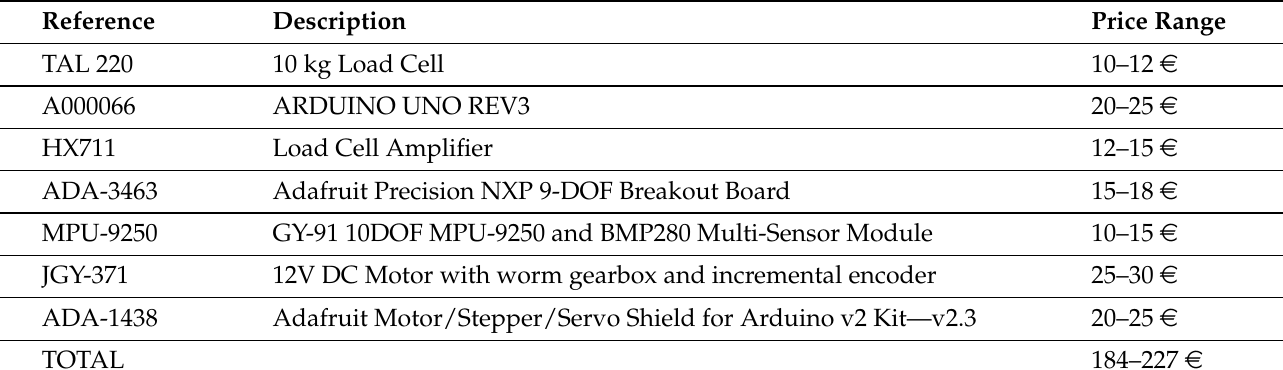
Figure 2. Designed robotic manipulator. Table 1. Bill of materials of the robotic